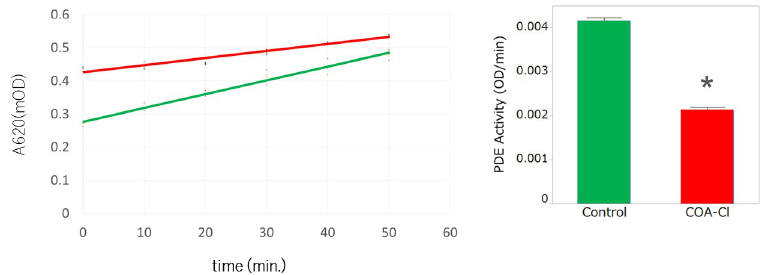
Fig 8. COA-C significantly induced PDE activity in hiPSC-CMs. PDE enzyme (20 mU/well) was incubated at 30˚C for the indicated times with cAMP (200 μ M) and 5’-nucleotidase (50 kU/well) with or without COA-Cl (1 mM). Reactions were terminated by the addition of 100 μ L of Green Assay Reagent and OD 620 nm read 30 min later. A standard curve of cAMP can be used to convert the OD 620 nm data to nmol of 5’-AMP. Each data point represents the mean and SEM of three independent experiments performed in